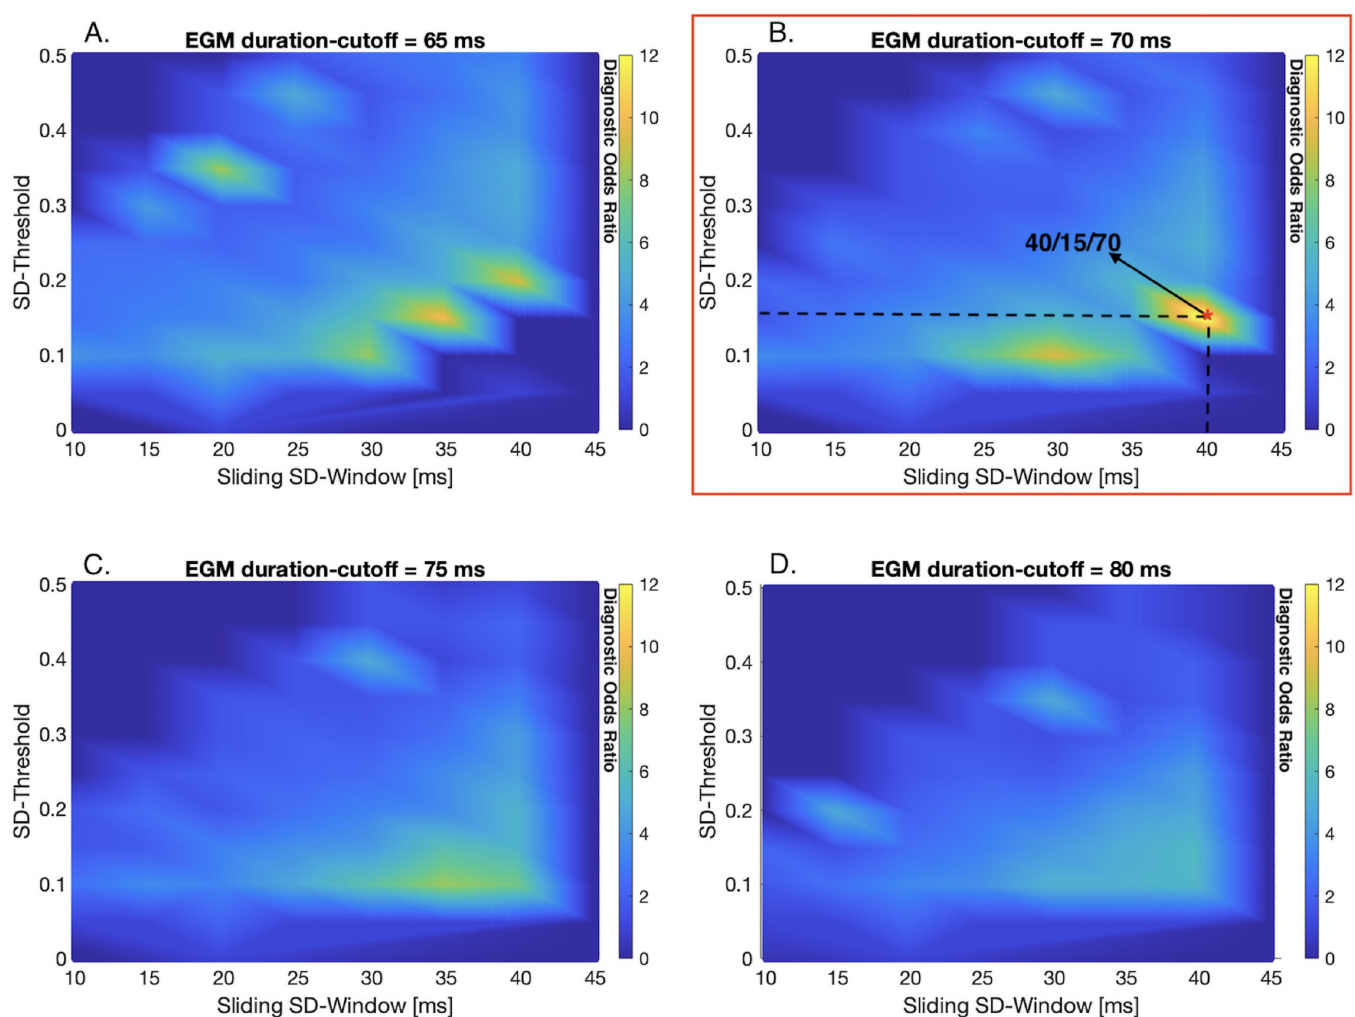
Fig 4. Diagnostic odds ratio color-coded maps demonstrate validation of signal processing parameters. According to the highest diagnostic odds ratio (DOR) value, the signal processing parameters sliding SD-window (test range: 10–45 ms) and SD-threshold (test range: 0.1–0.5) are validated. The color-coded scale represents linear interpolation of DOR, with yellow being the highest and blue the lowest. (A) The parameter sets 35/10/65 and 40/20/65 (SD-window size/SD-threshold/EGM duration cutoff) result in a DOR of 10.11. (B) The parameter set 40/15/70 results in the highest DOR of 12.77 (red asterisk). This parameter set leads to a DOR of 12.77, describing a 12.77-times higher probability that ablation points were set in areas with a mean EGM duration > 70 ms compared to areas with an EGM duration � 70 ms (95% Cl: 3.0848–56.1523, P = 0.0005). (C) The parameter set 35/10/75 results in a DOR of 8.19. (D) The parameter set 40/10/80 results in a DOR of 5.53.